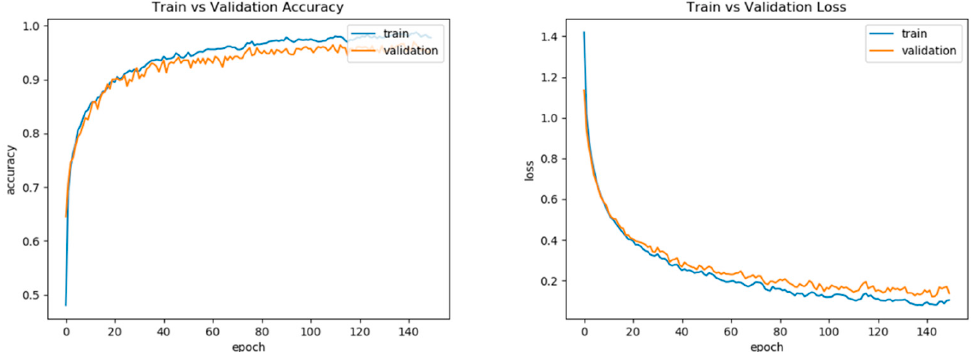
Figure 9. The accuracy ( Left ) and loss ( Right ) of the trained model based on bidirectional LSTM. The CSI values for various activities vary, which affects the recognition accuracy. For each activity, we use a confusion matrix (also known as an error matrix) to indicate how well our suggested classifier performed. The rows correspond to the predicted categories, while the columns correspond to the actual classes. The results in the confusion matrix (Figure 10) show an accuracy of over 88% for all of these activities. For “LieDown”, “FallDown”, “Jump”, “Sit”, “StandUp”, and “Walking”, the mean detection rates for the six movements were 97%, 99%, 100%, 88%, 91%, and 99%, respectively.